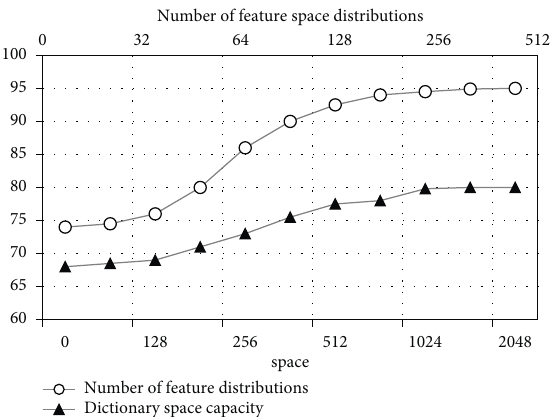
Figure 5: The impact of parameter changes on other indicators.